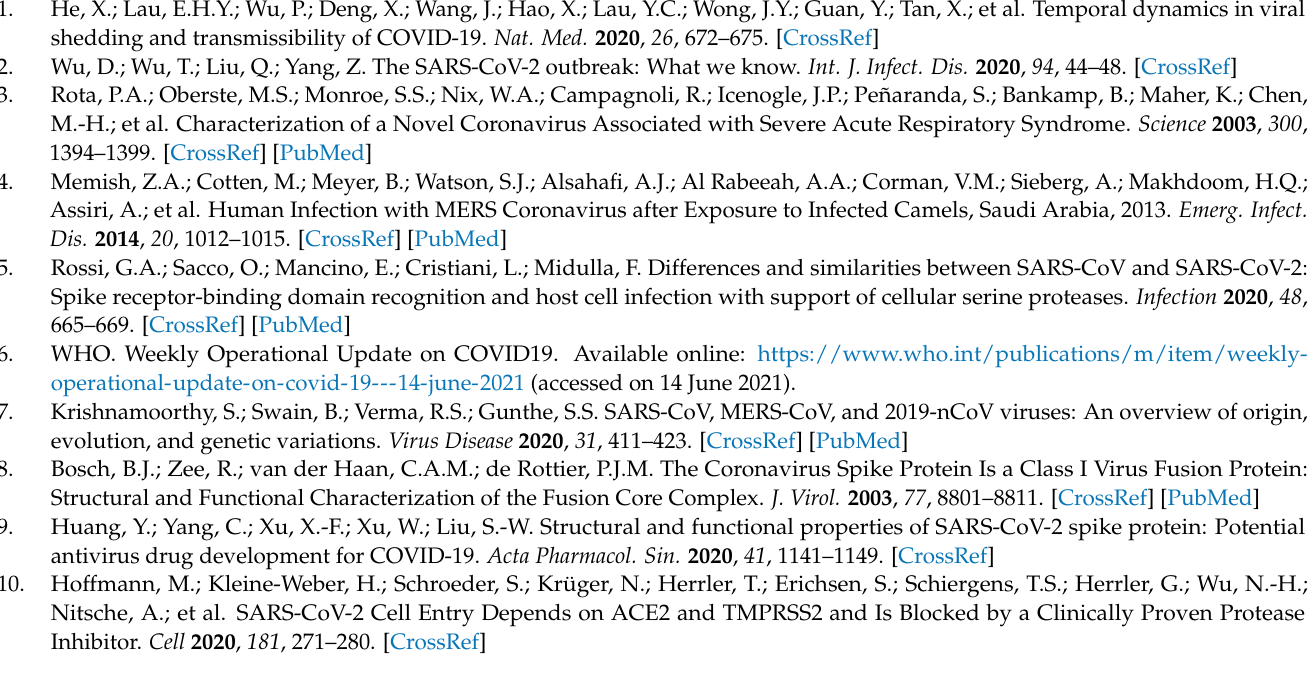
Figure S2: Alignment of wtACE2 and ∆ cytACE2, Figure S3: Cell surface localization and binding affinity with spike proteins of wtACE2 and ∆ cytACE2 on BHK21 cells, Figure S4: Production and validation of spike S1-Fc and RBD-Fc